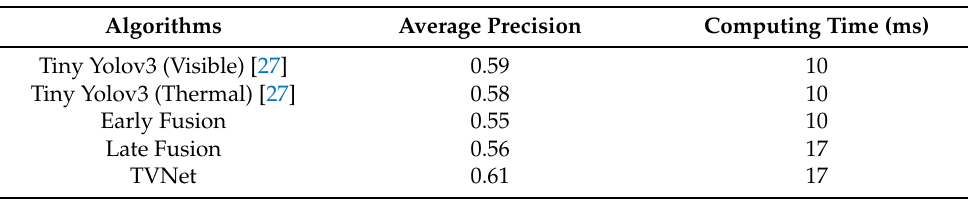
Table 4. Comparative Analysis of the TVNet on the daytime subset.